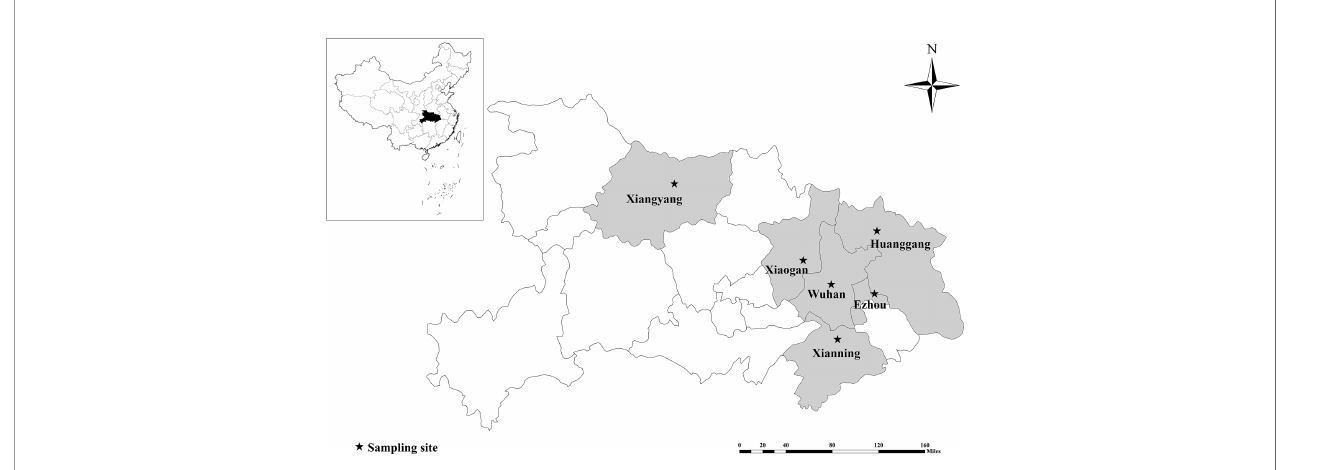
FIGURE 1 | Sampling sites in pigs in Hubei Province, China. Sampling locations are marked in dark